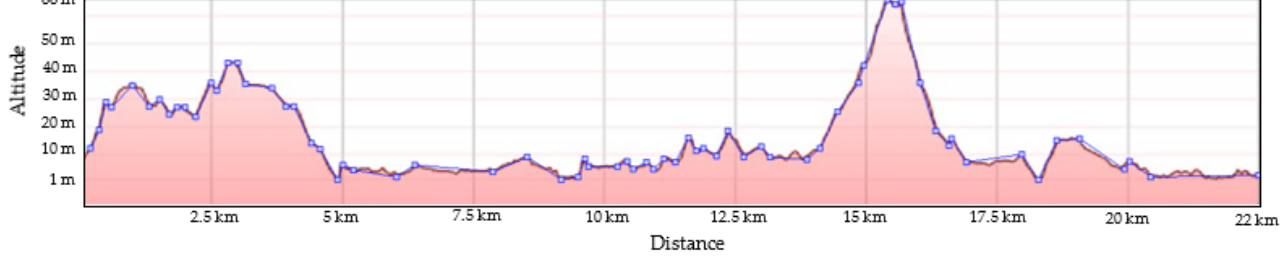
Figure 11. Elevation profile.